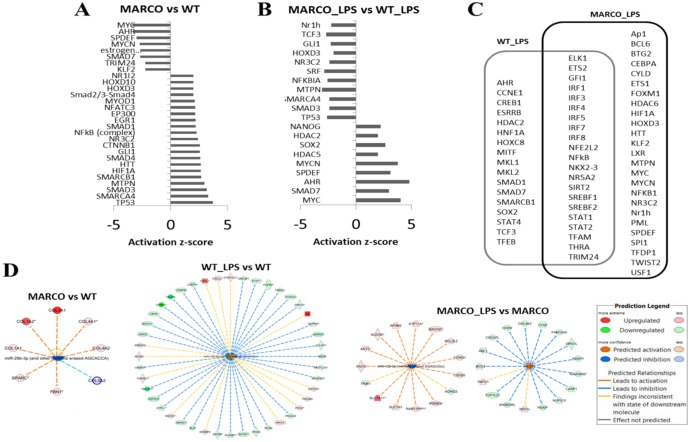
Comparison of Upstream Regulator status between WT and MARCO−/− DC.Differentially expressed genes (fold change of 2 or higher) were processed through Ingenuity Pathway Analysis to predict the downstream regulators whose activation status was affected by the absence of MARCO in resting cells (A) or LPS-challenged cells (B). The Venn diagram in (C) shows the transcription factors that respond to LPS in WT (WT_LPS) and MARCO−/− (MARCO_LPS) DC. Transcription factors that reached the significant activation z-score of −2 or +2 are shown. (D) Shown are representative microRNAs that reached the significant activation z-score of −2 or +2. The IPA tool predicts a microRNA to be activated when enough differentially downregulated genes fall among the targets for this microRNA. The inhibition status is attributed when the opposite occurs.